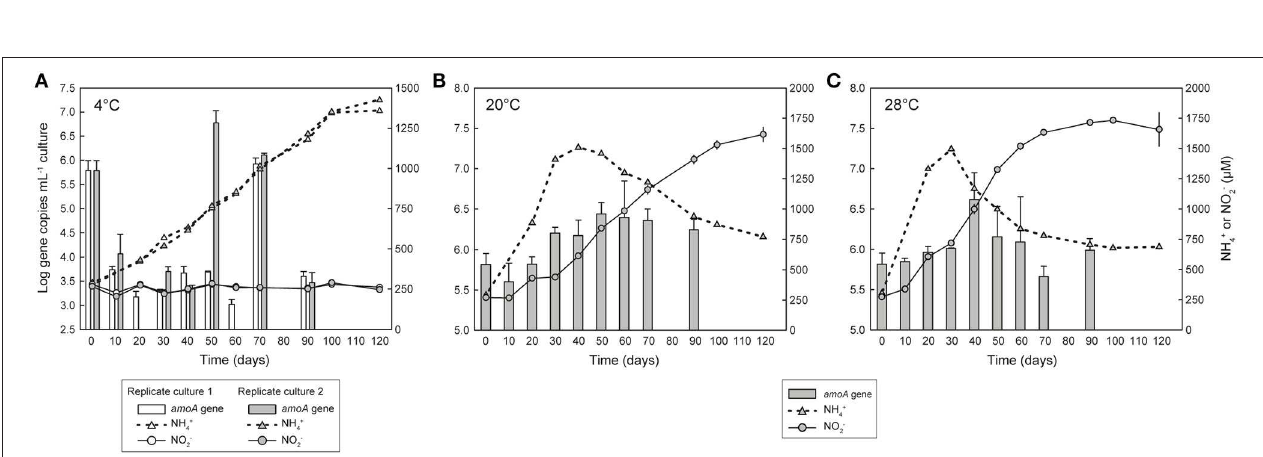
FIGURE 2 | Growth of Ca. N. arcticus Kfb with or without nitrite production in enrichment cultures at (A) 4 ◦ C, (B) 20 ◦ C, or (C) 28 ◦ C. Cultures were grown in mineral medium supplemented with 1mM urea. Growth was determined based on quantification of archaeal amoA gene copies with qPCR (gray bars). Solid and dotted lines represent cumulative net NO − 2 production and net NH + 4 release and consumption, respectively. (A) shows two replicate cultures with active growth but no NO − 2 production; the third replicate culture is not shown, as neither growth nor NO − 2 production were detected. Error bars in (B,C) represent the standard deviation of triplicate cultures; error bars in (A) represent triplicate qPCR reactions. Some error bars are smaller than the symbols and thus are not visible.